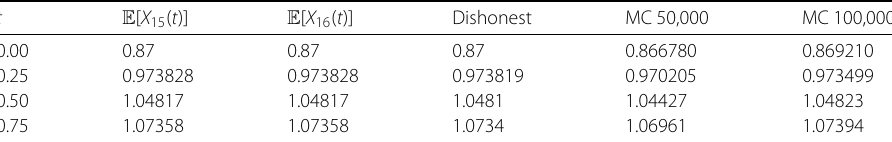
Table 14 Approximation of the expectation of the solution stochastic process. Example 4.4, assuming dependent initial conditions